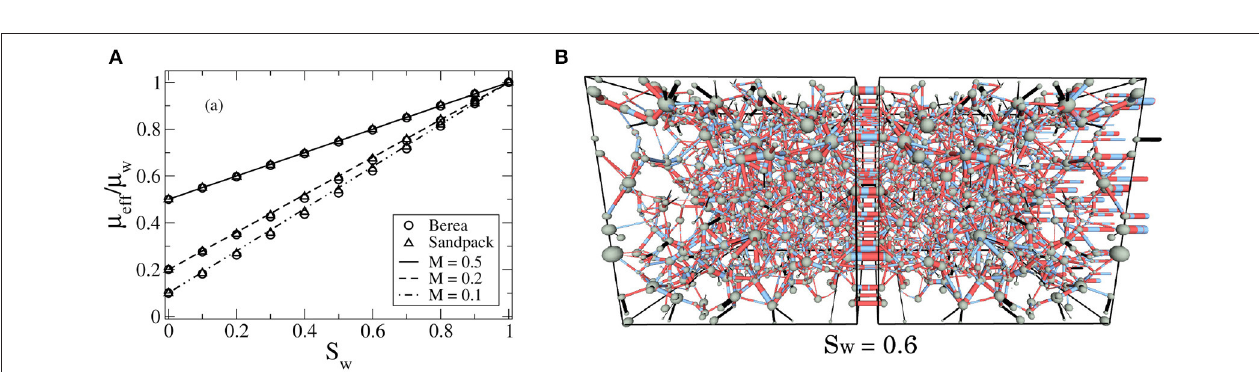
FIGURE 2 | (A) Plot of ( µ eff /µ w ) α for 3D networks reconstructed from Berea sandstone and sandpack samples for the simulations with four interfaces (C). Results are consistent with Equation (14) (straight lines) with α 1, similar to the 2D networks. A snapshot of fluids in Berea sandstone in the steady state for model C is = shown in (B) , where blue and red are the wetting and non-wetting fluids respectively.